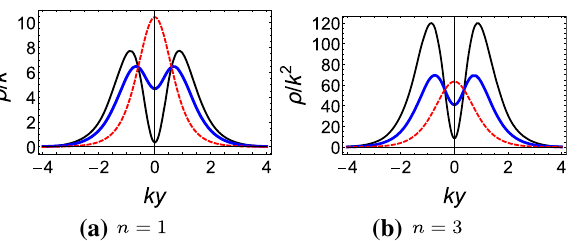
Fig. 2 The energy density of model 1 with v = 1, and n = 1 (the left panel) and n = 3 (the right panel). In the left panel we set k 2 α = − 0 . 06 for the black line, k 2 α = − 0 . 03 for the thick blue line, and k 2 α = 0 . 01 for the dashed red line. In the right panel we set k 2 α = − 0 . 018 for the black line, k 2 α = − 0 . 0073 for the thick blue line, and k 2 α = 0 . 00014